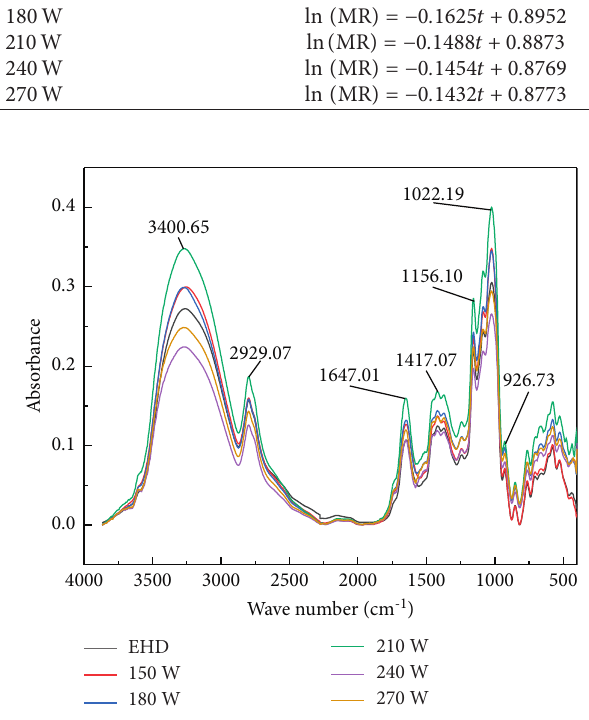
Figure 8: Infrared spectra of potato slices under different ultra- sonic pretreatment